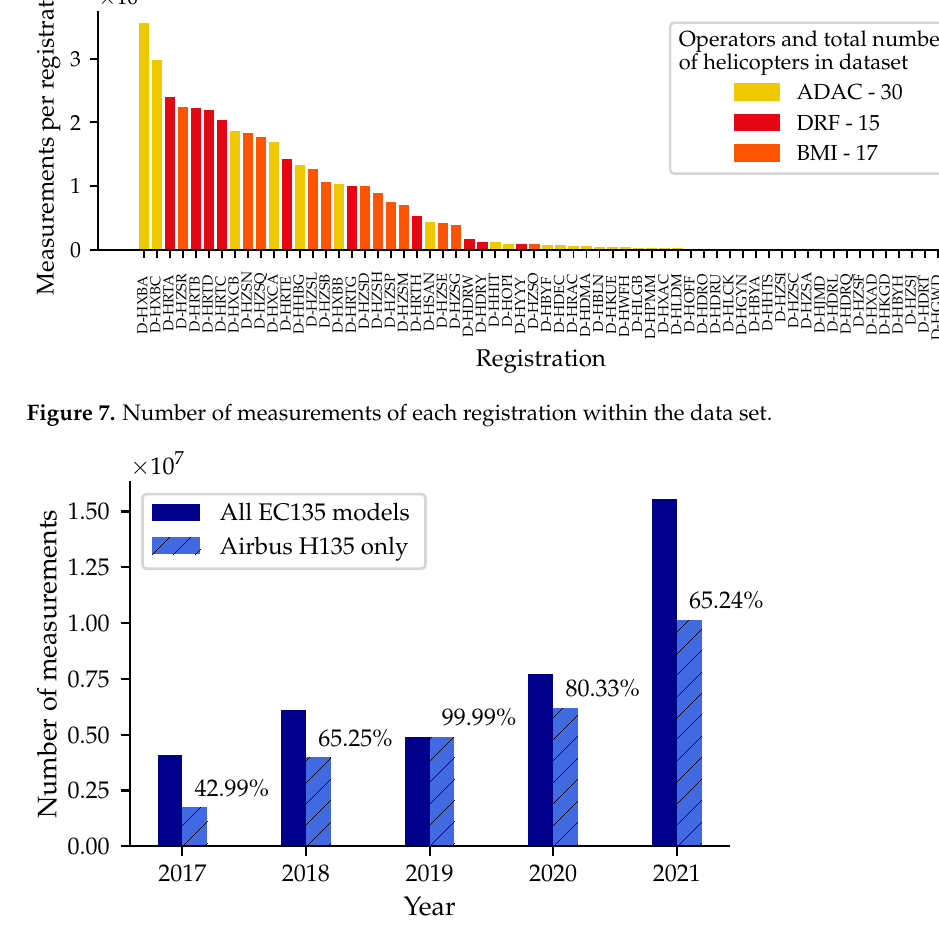
Table 2. Overview of the selected helicopters.